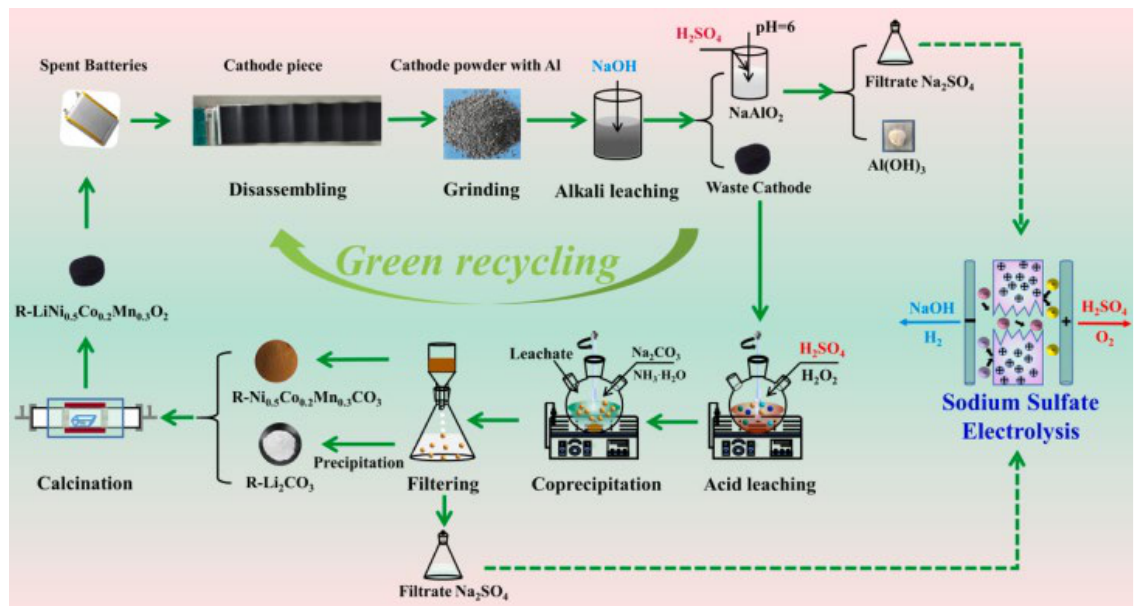
Figure 2. Schematic representation of the green recycling strategy of waste LIBs proposed by Fang and co-workers. Used with permission of Elsevier Science & Technology Journals, from Ref. [51]; permission conveyed through Copyright Clearance Center,